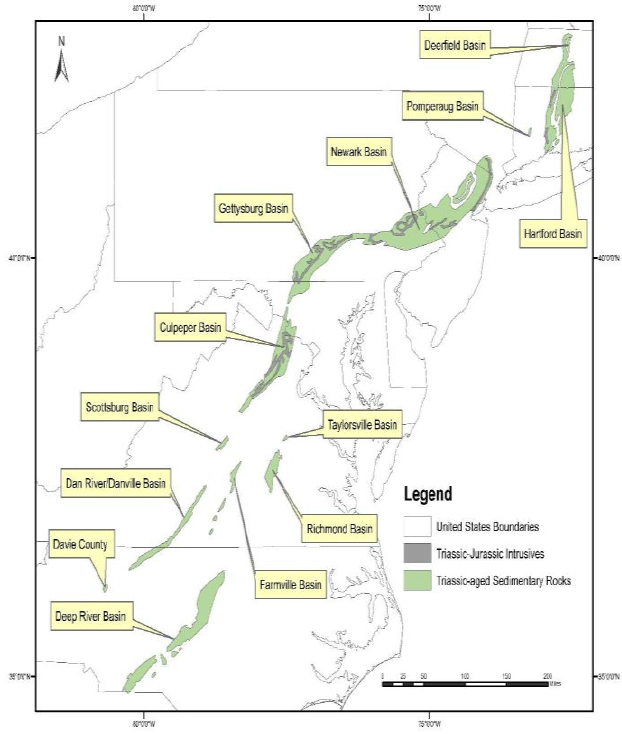
Figure 3. Location of the Mesozoic rift basin complex along the east coast of the U.S. GIS data obtained from the U.S. Geological Survey.